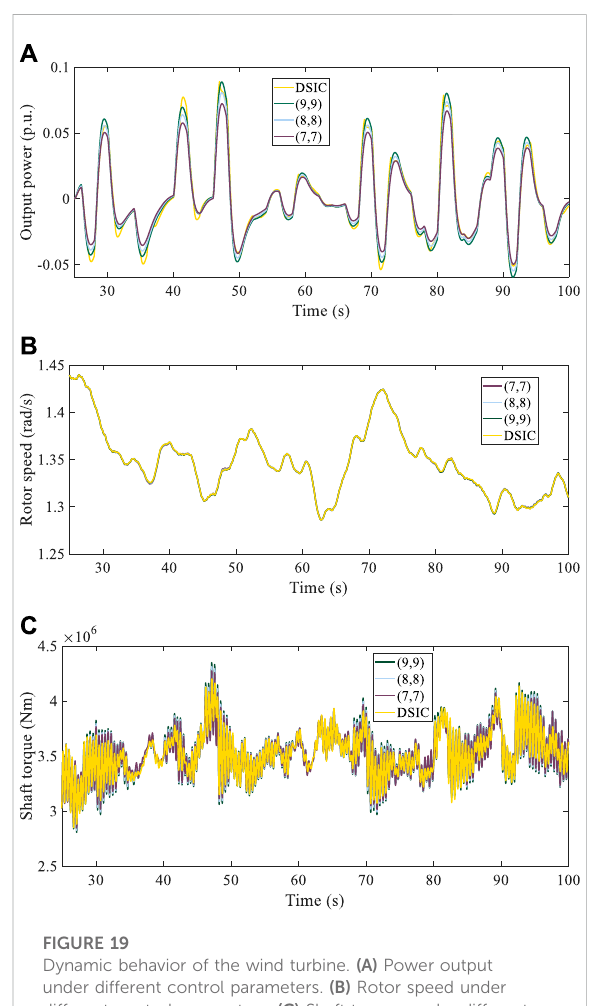
FIGURE 19 Dynamic behavior of the wind turbine. (A) Power output under different control parameters. (B) Rotor speed under different control parameters. (C) Shaft torque under different control